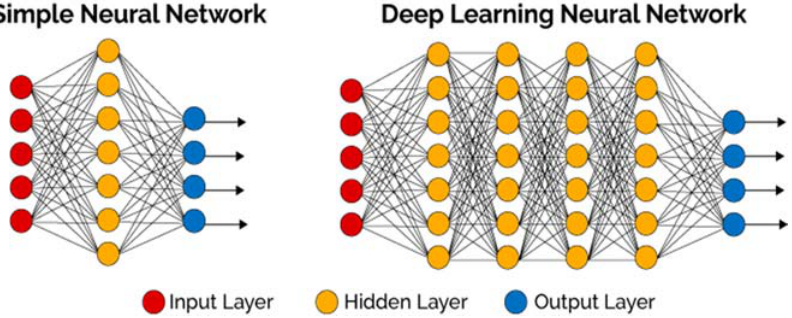
Figure 2. Comparison between simple neural network (NN) and deep NN; simple neural networks contain only one hidden layer as well as the input and output layers, while deep learning neural networks contain more than one hidden layer. In this case, there are four hidden layers between the input and output layers [17].